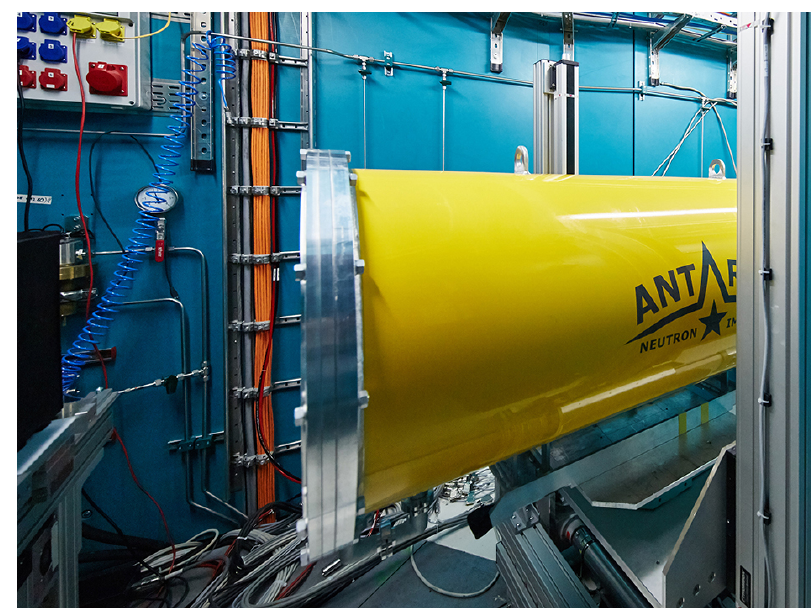
Figure 1: Instrument ANTARES (Copyright by B.